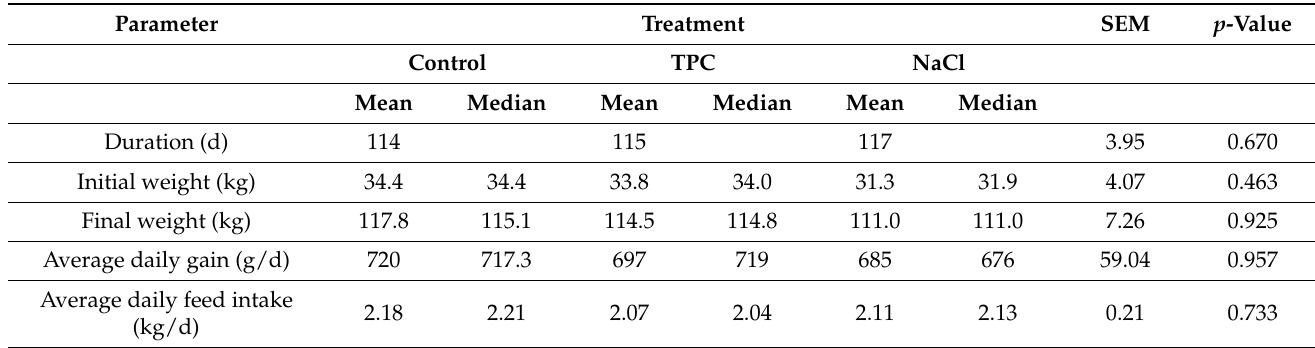
Table 3. Performance data a of fattening pigs in three treatment groups (mean and median of three batches in each group): the control group (control) received the normal feed used on the farm, the tripotassium citrate (TPC) and the sodium chloride (NaCl) groups received the normal feed supplemented with 0.25% TPC and 0.20% NaCl,